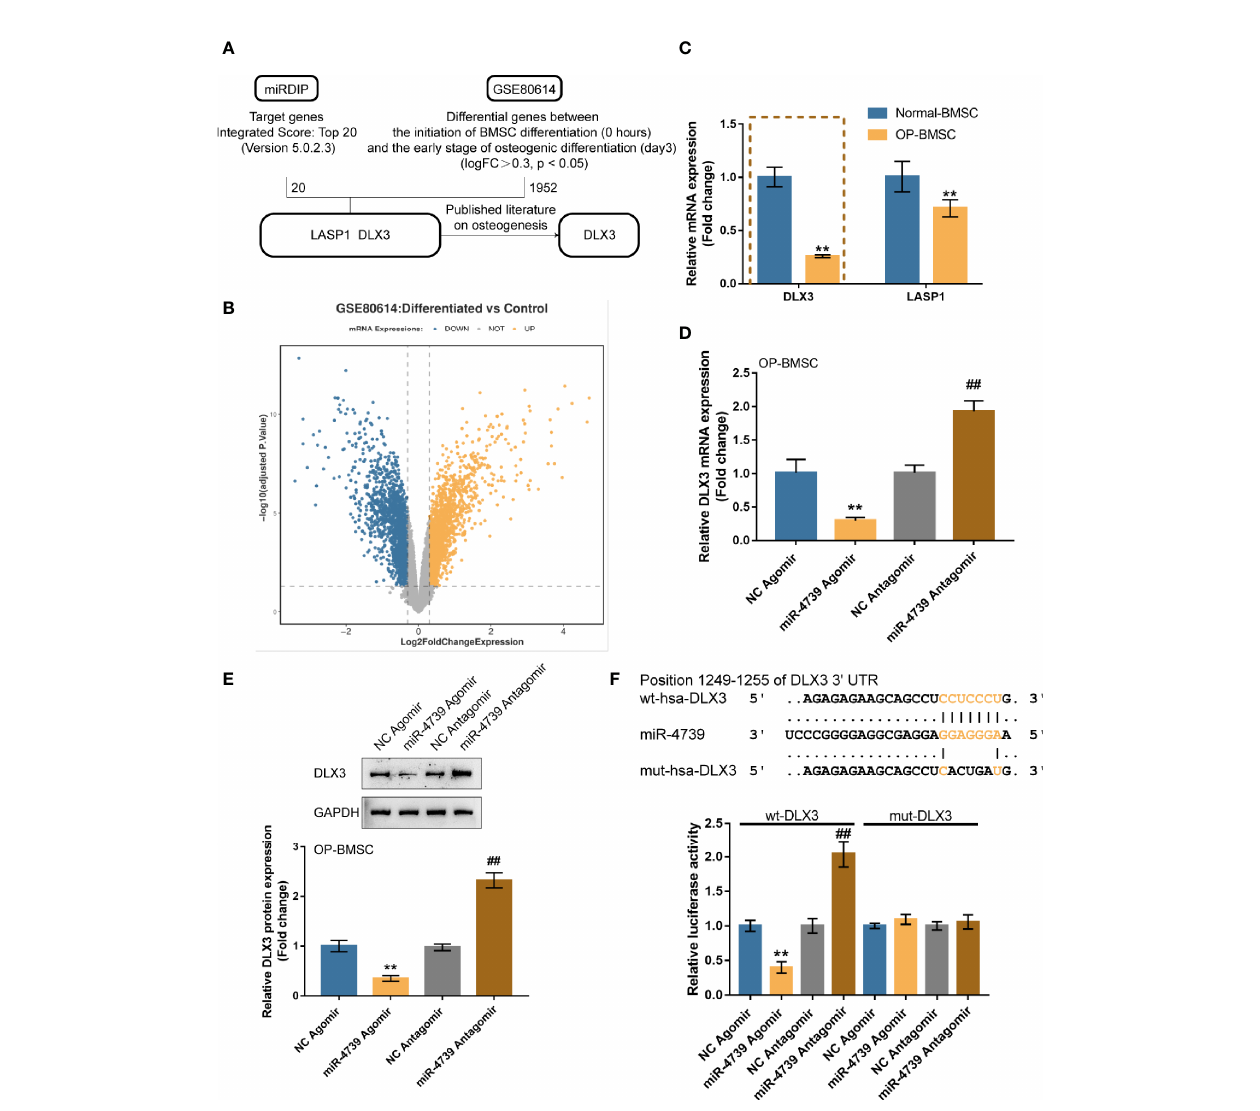
FIGURE 5 | miR-4739 targets DLX3 and inhibits DLX3 (A, B) miRDIP was used to predict miR-4739 targets (top 20 highest integrated score genes); differentially expressed genes in BMSCs on day 0 and 3 of osteogenic differentiation were analyzed according to GSE80614 (logFC >0.3, P < 0.05). These two datasets intersected in LASP1and DLX3. (C) The expression of DLX3 and LASP1 in normal or osteoporotic BMSCs. n=3. (D) Osteoporotic BMSCs were transfected with agomir-4739 or antagomir-4739 and examined for DLX3 expression using qRT-PCR. n=3. (E) DLX3 protein levels using Immunoblotting. n=3. (F) Wild- and mutant- type DLX3 luciferase reporter vectors were generated and co-transfected in 293T cells with agomir-4739 or antagomir-4739; the luciferase activity was determined. n=3. ** P < 0.01, compared to NC agomir; ## P < 0.01, compared to NC